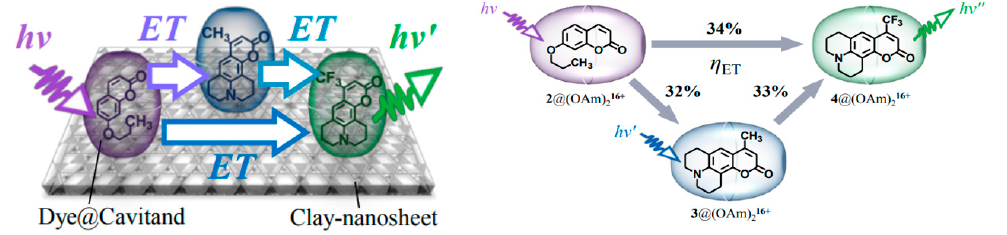
Figure 45. Multistep energy transfer reaction system [167].